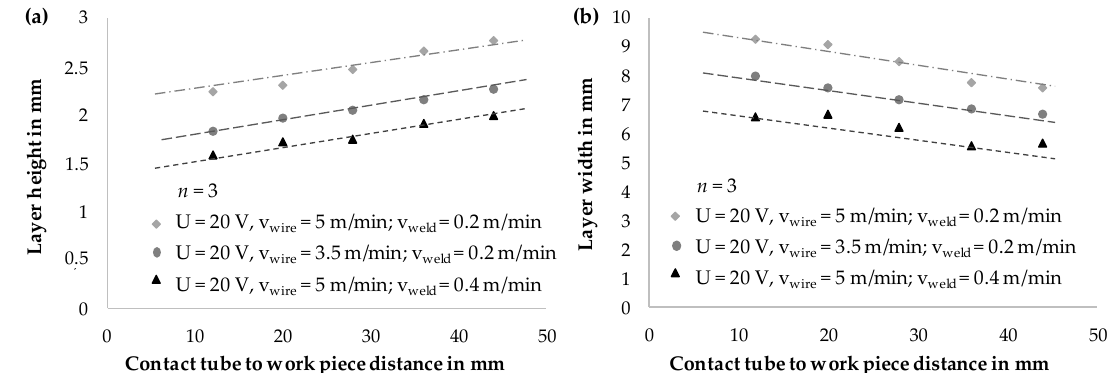
Figure 10. ( a ) Determination of layer height and ( b ) analysis of layer width for 3 parameter sets and adjusted CTWD.